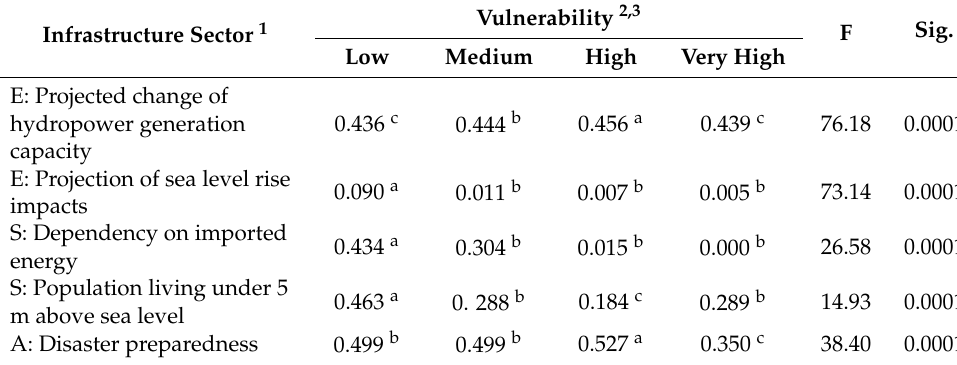
Table 9. Climate change vulnerability classes by infrastructure sector vulnerability